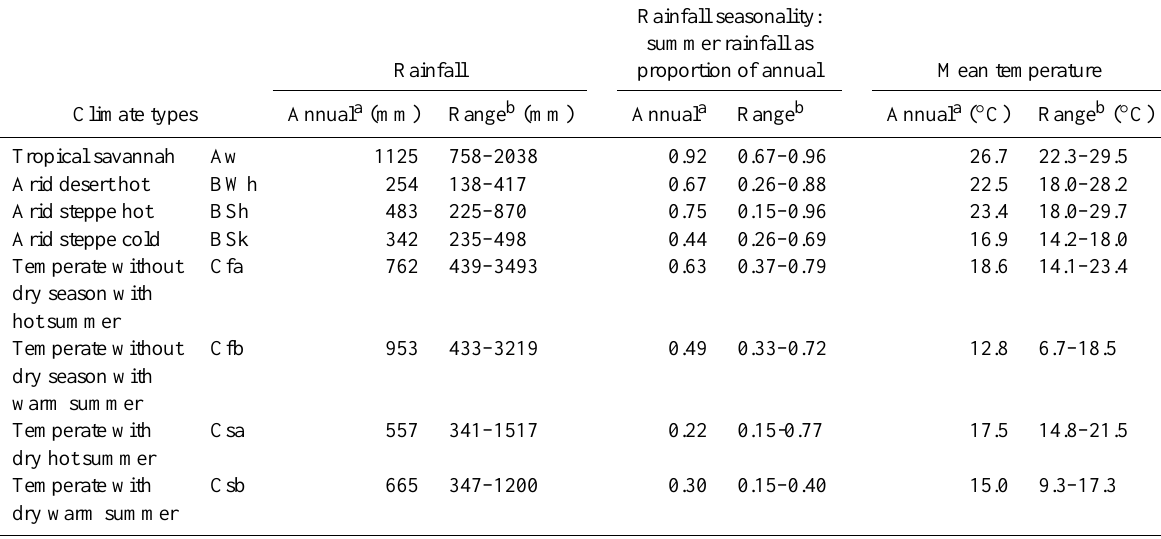
Table 1. Characteristics of selected climate zones.